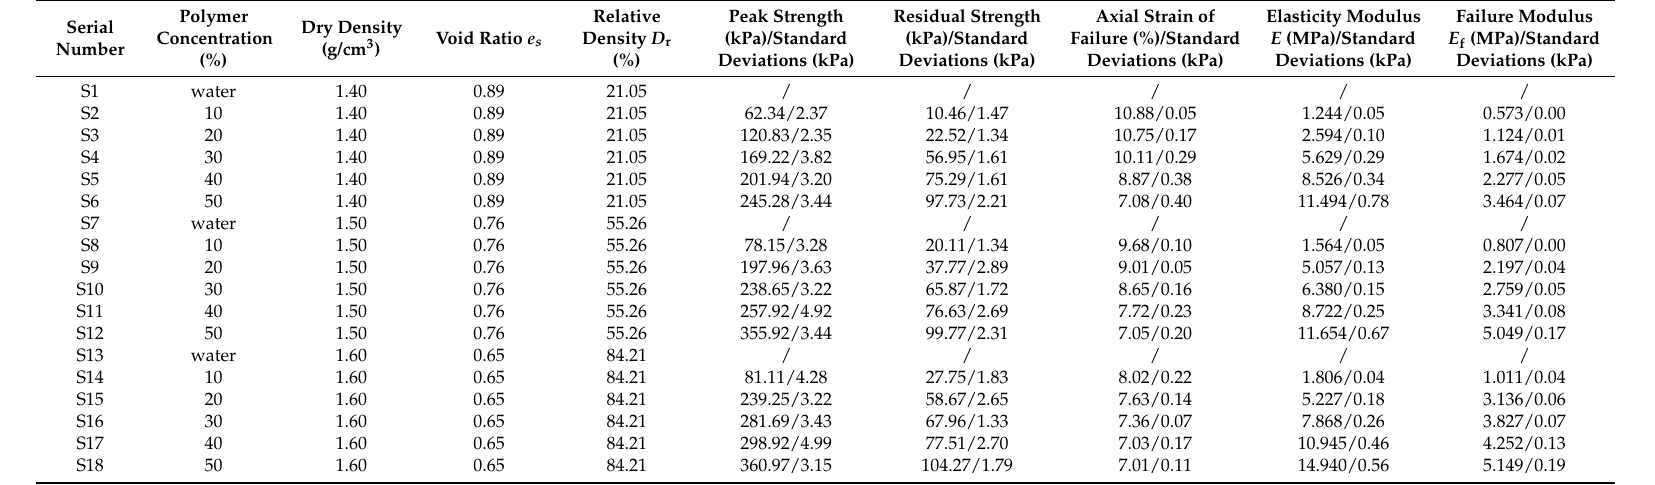
Table 1. Results of unconfined compression strength